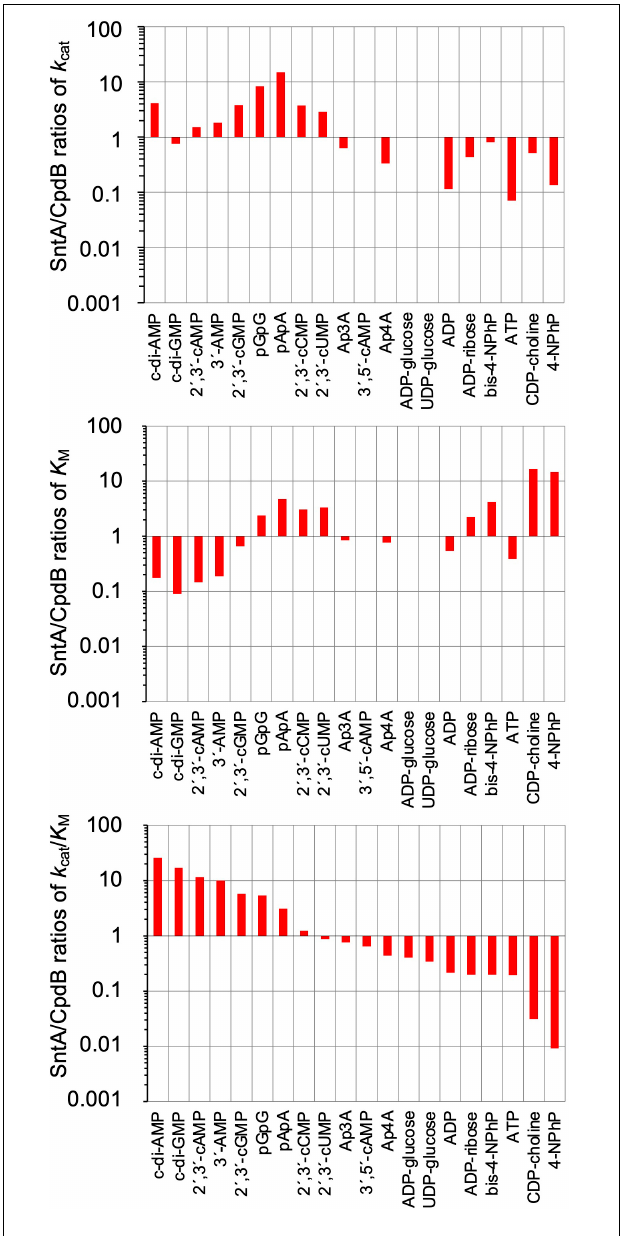
FIGURE 2 | Comparison of substrate specificities of Streptococcus suis SntA and Escherichia coli CpdB. Kinetic parameters shown in Table 1 are divided by kinetic parameters of CpdB (López-Villamizar et al., 2016). Results are shown in log scale. In all panels, substrates are ordered by decreasing SntA/CpdB ratios of catalytic efficiency k cat / K M . Two groups of substrates can be distinguished depending on whether SntA/CpdB ratio of efficiency was clearly higher or lower than unity (lower